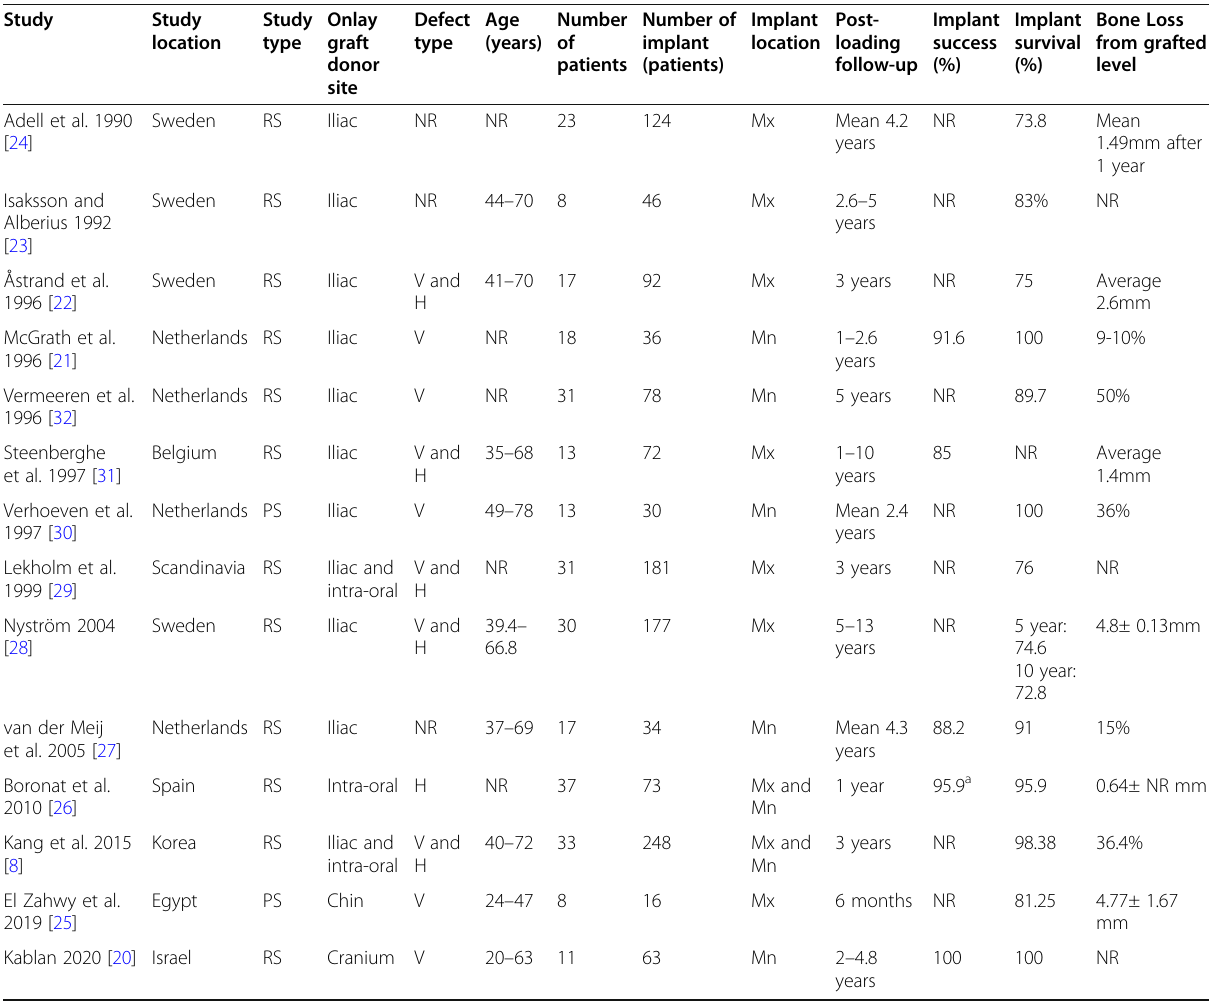
Table 1 Characteristics of single arm studies